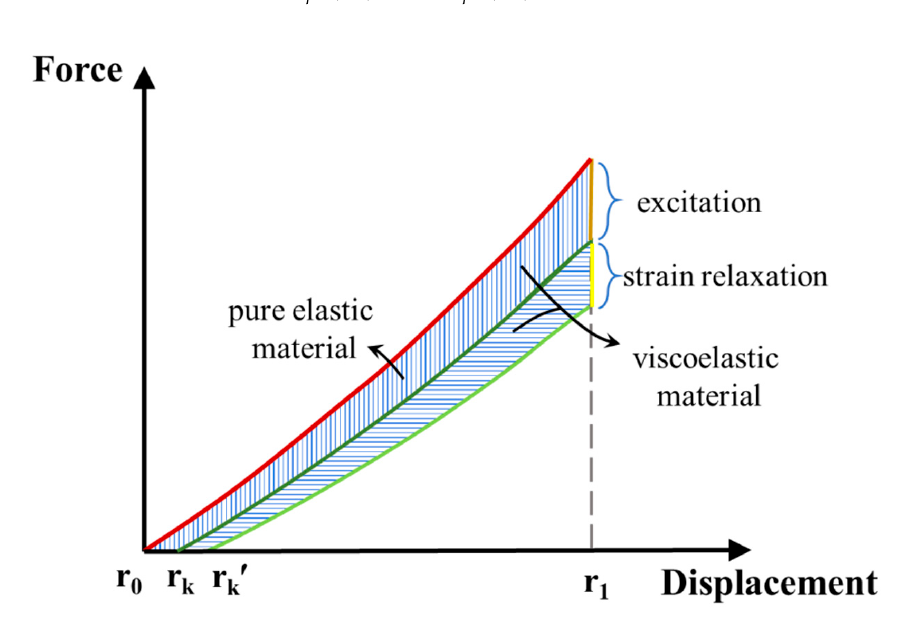
Figure 5. Force-displacement curve of the DEG under different elasticity conditions.